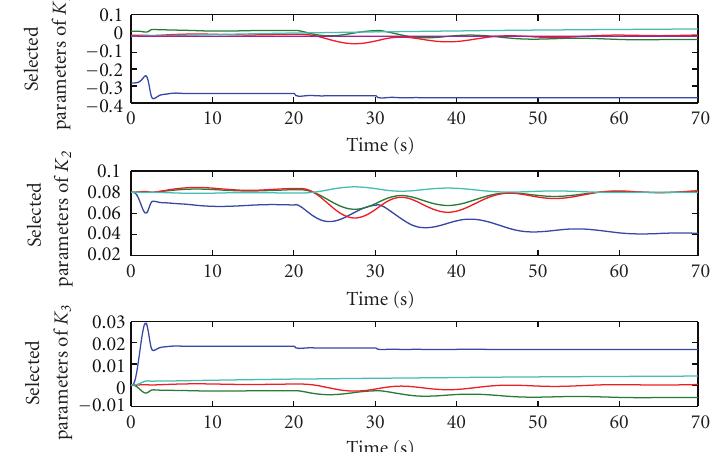
Figure 23: Time history of selected adaptive controller